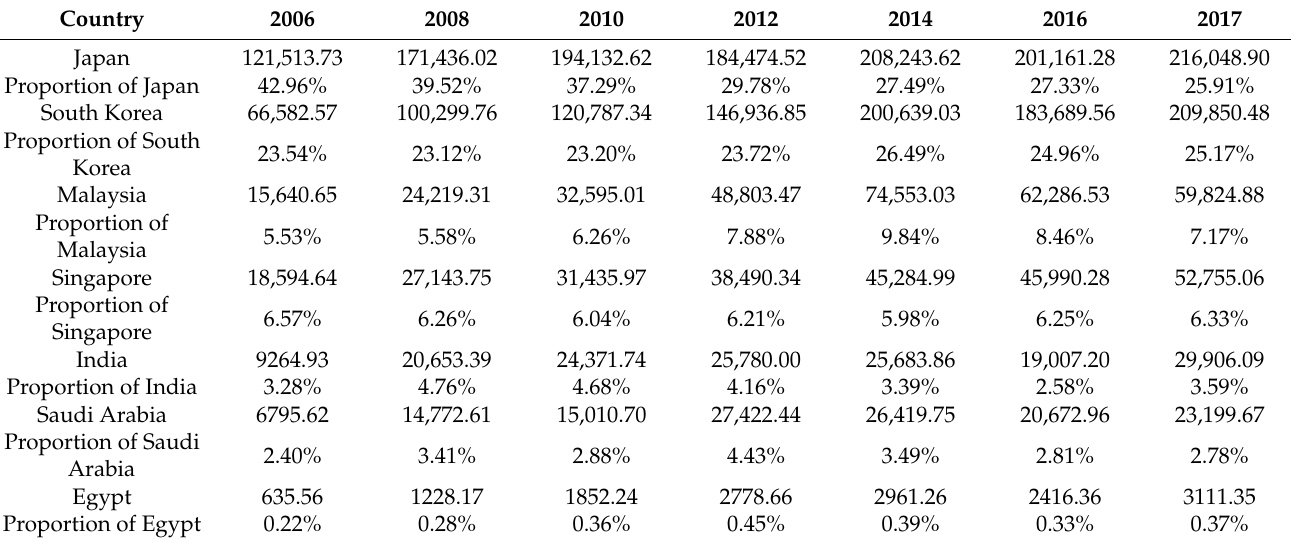
Table 2. The variation in the geo-economic linkage intensity of regional powers (million